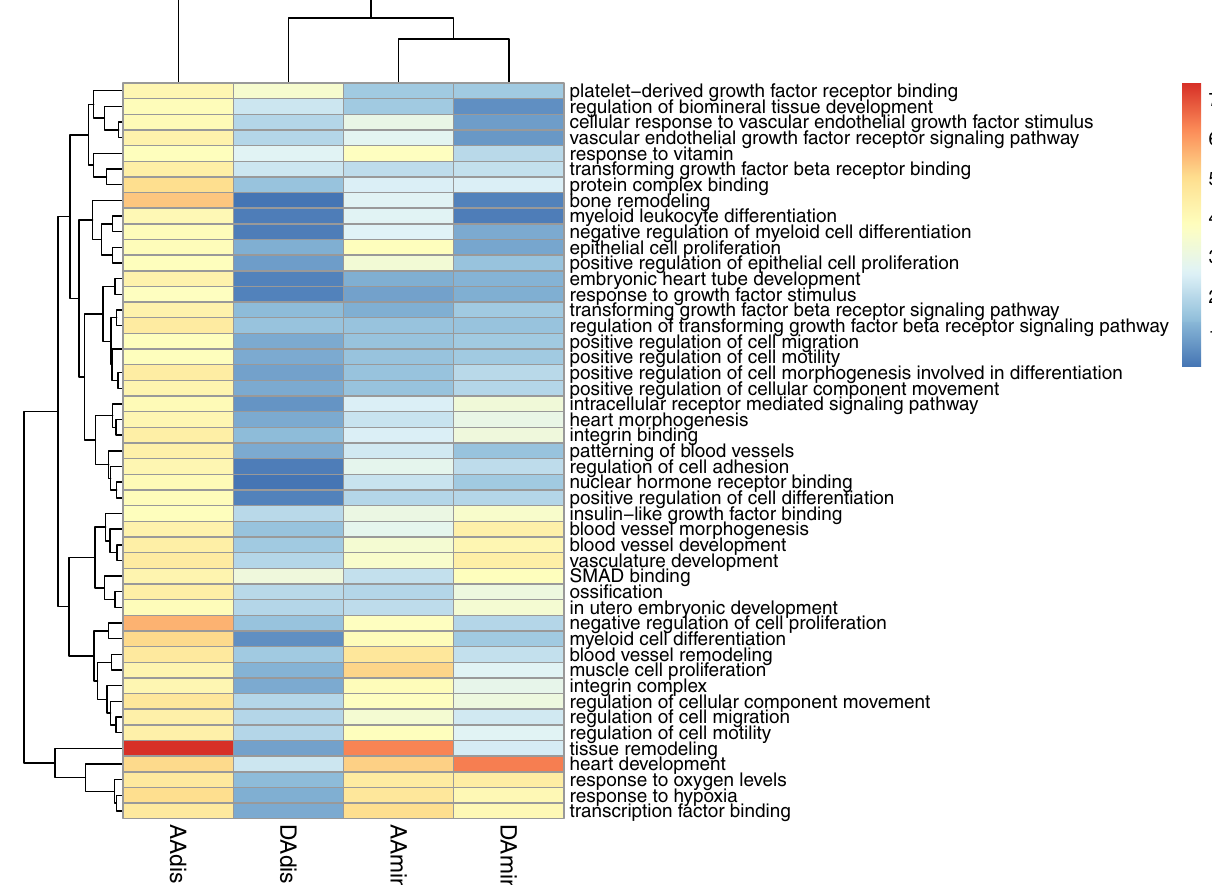
presented. Full results can be found in Supplementary Data 11c. AAdis ascending aortic distensibility, AAmin ascending aortic minimum area, DAdis descending aortic distensibility, DAmin descending aortic minimum